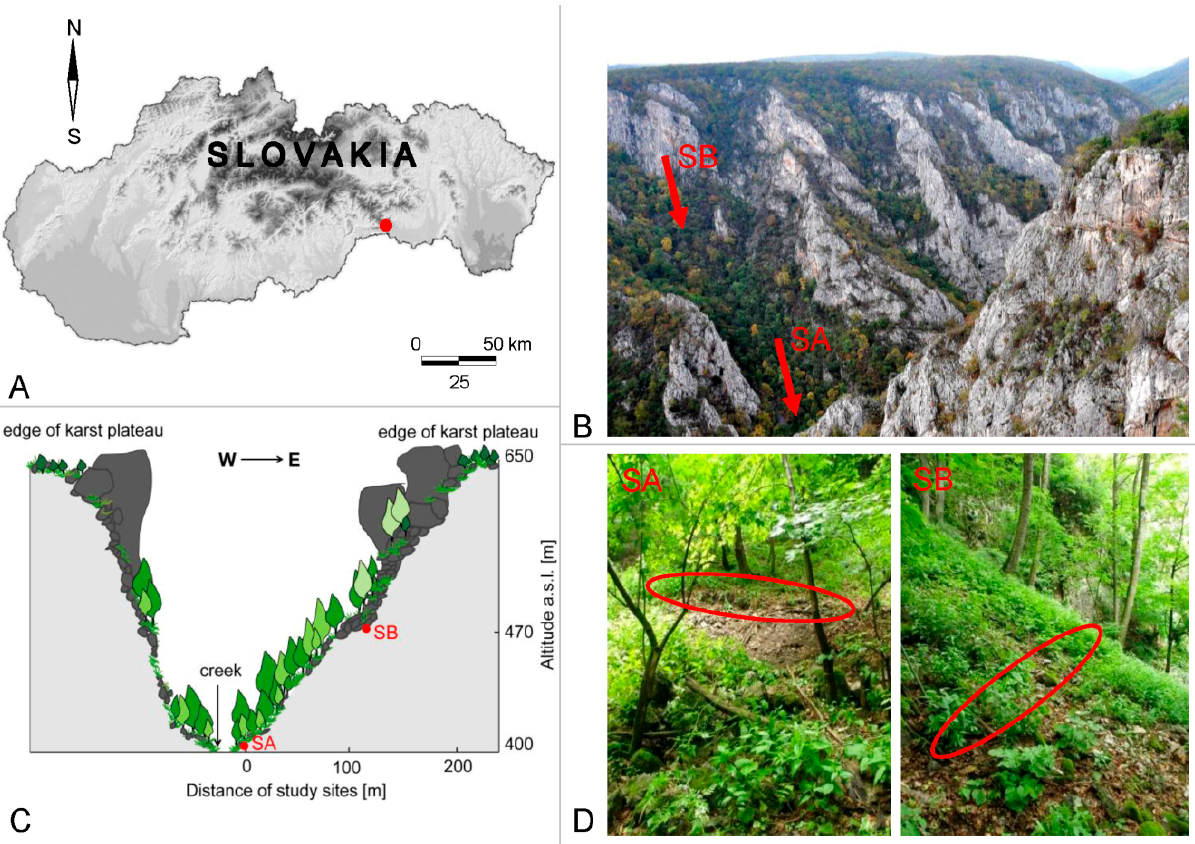
Figure 1. ( A ) Location of the Zádiel Valley; ( B ) Scree slope in the Zádiel Valley with the position of the study sites SA and SB (Photo: Ľ . Ková č ); ( C ) Schematic cross-section of the valley with the position of the study sites on the scree slope; ( D ) Red ellipse—position of subterranean traps at sites on the slope (Photo: P. Ľ uptá č ik).